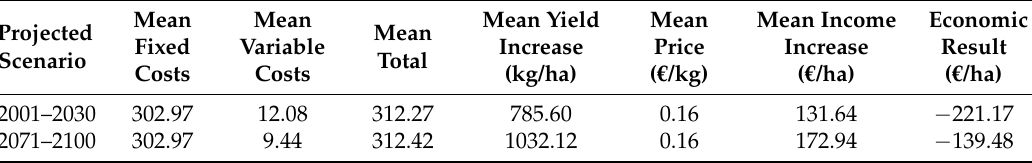
Table 9. The predicted costs of the irrigation of barley and its economic